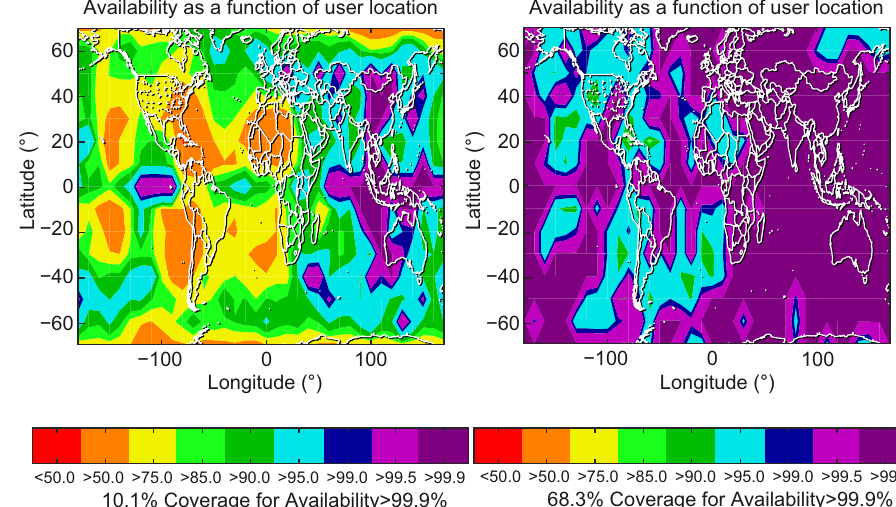
40 m and HAL 35 = =